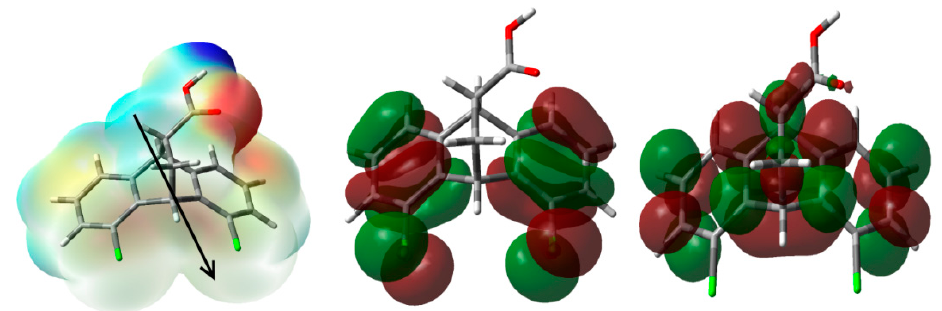
Figure 9. The MEP, HOMO and LUMO of 5 .